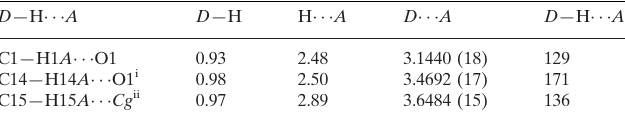
Hydrogen-bond geometry (A˚ , (cid:5)